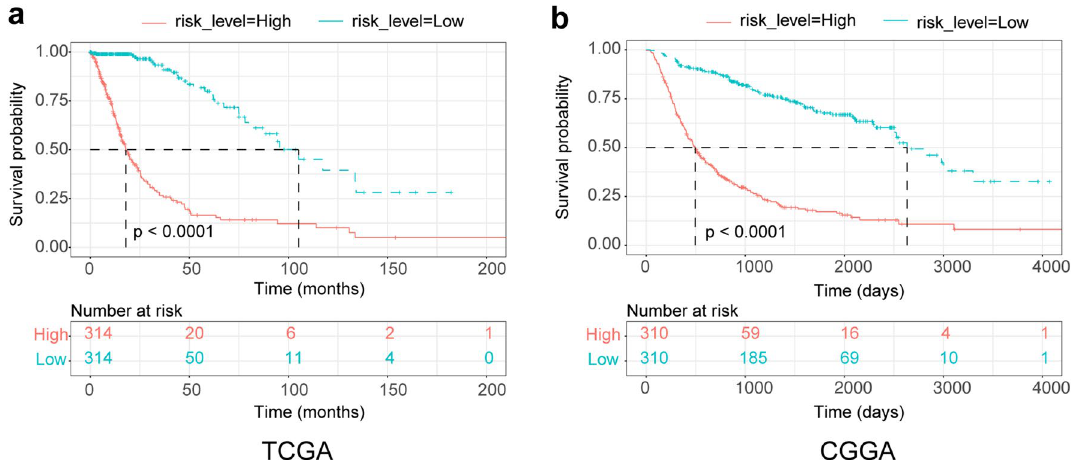
Figure 2. Outcome prediction for the patients in the TCGA and CGGA cohorts. ( a ) Kaplan–Meier survival curves of the high-risk and low-risk groups in all gliomas evaluated in the TCGA data set. ( b ) Kaplan–Meier survival curves of the high-risk and low-risk groups in all gliomas evaluated in the CGGA data